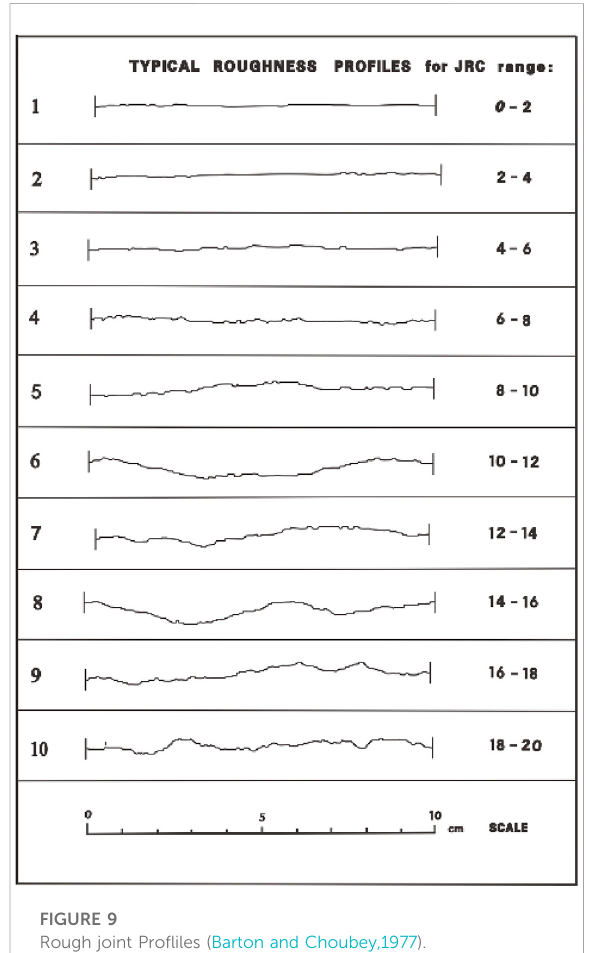
FIGURE 9 Rough joint Pro fl iles (Barton and